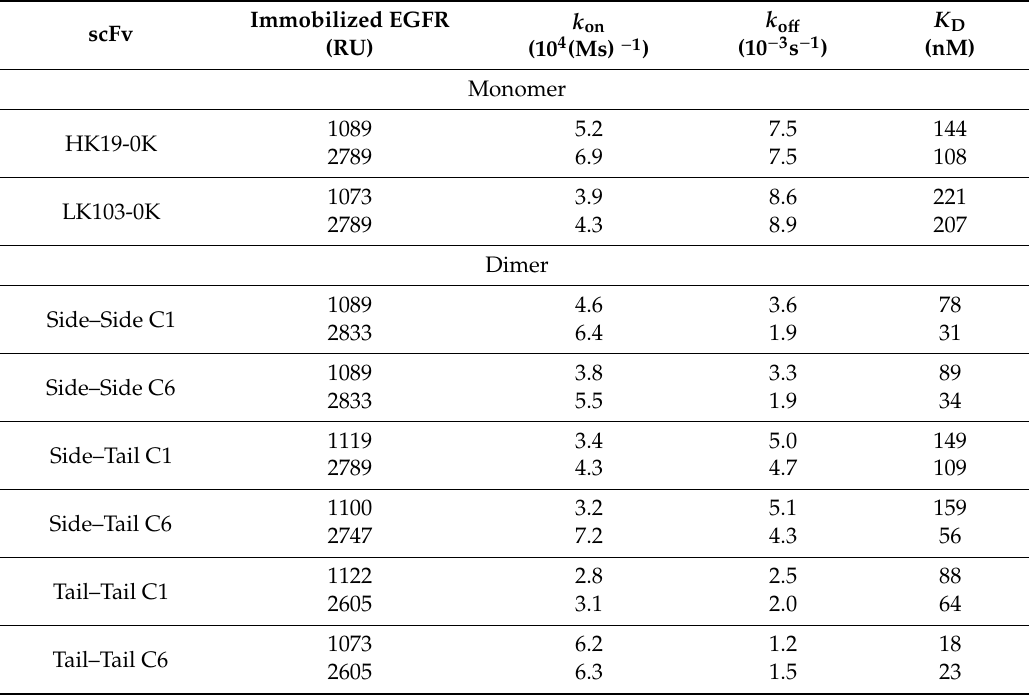
Table 4. Surface plasmon resonance measurements for the binding a ffi nity of scFv dimers with respect to